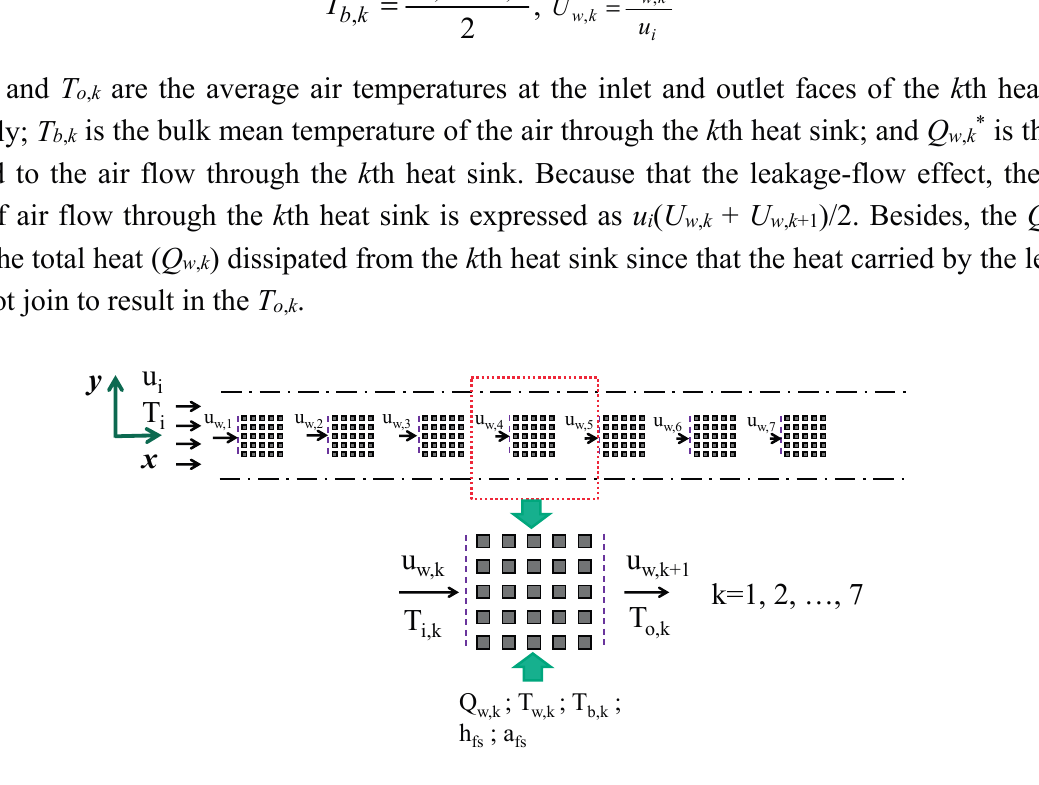
Figure 16. Energy-balance schematic diagram for the air flow heated via the heat